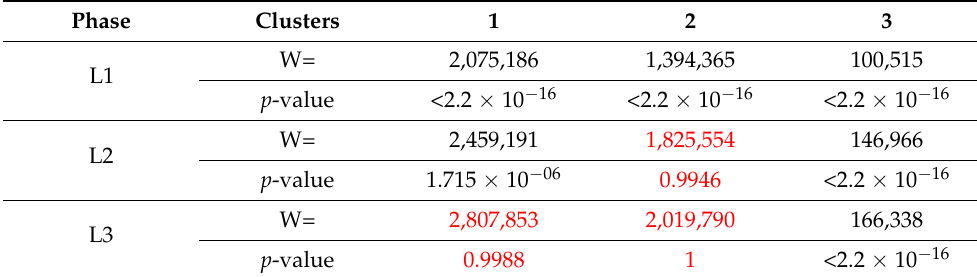
Table 9. Wilcoxon rank-sum test of the shift parameter for voltage ( α = 0.05) in each